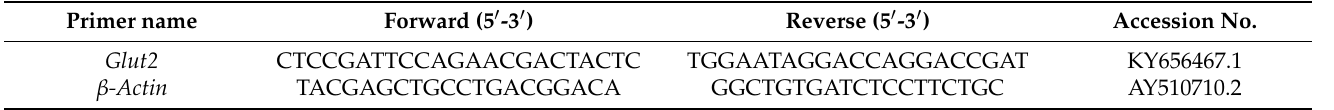
Table 2. The primer sequences designed for the quantitative expression of glut2